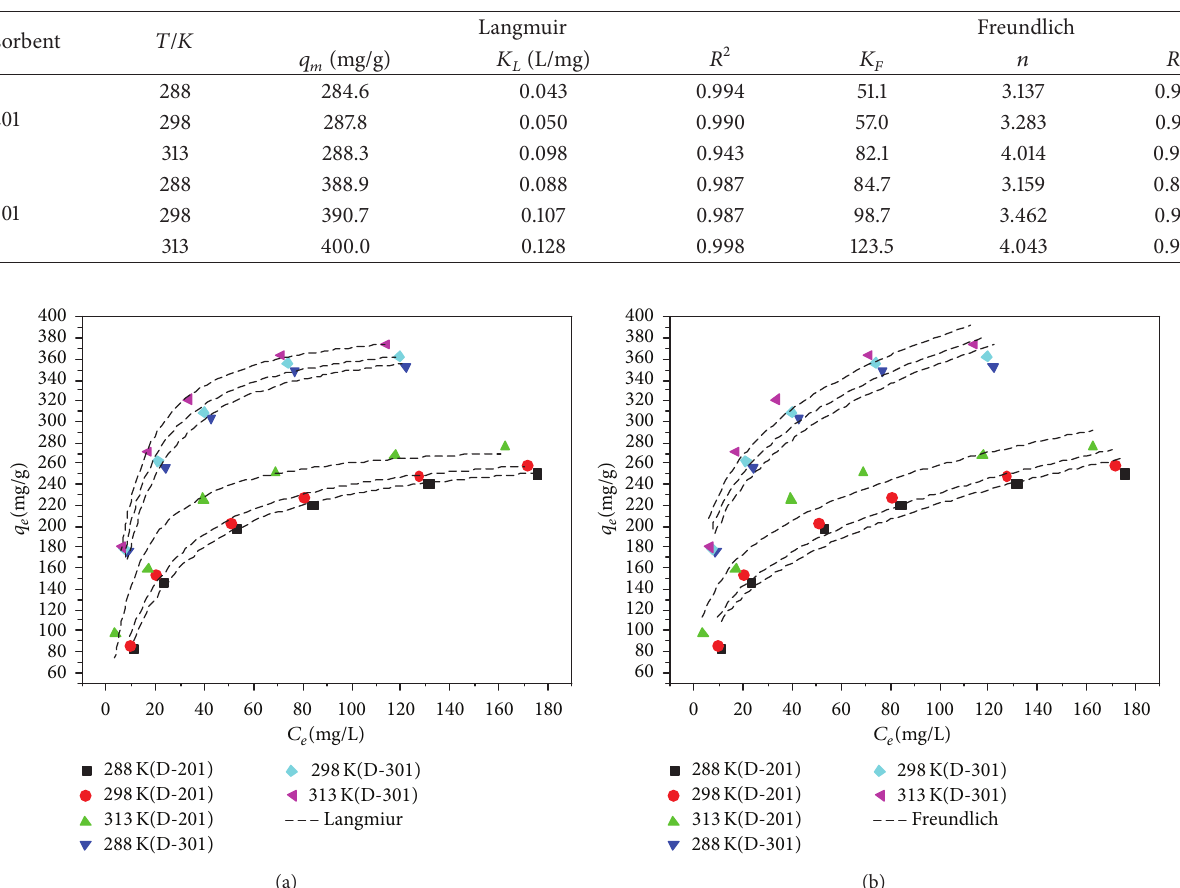
Table 2: Adsorption isotherm parameters of D-201 and D-301.